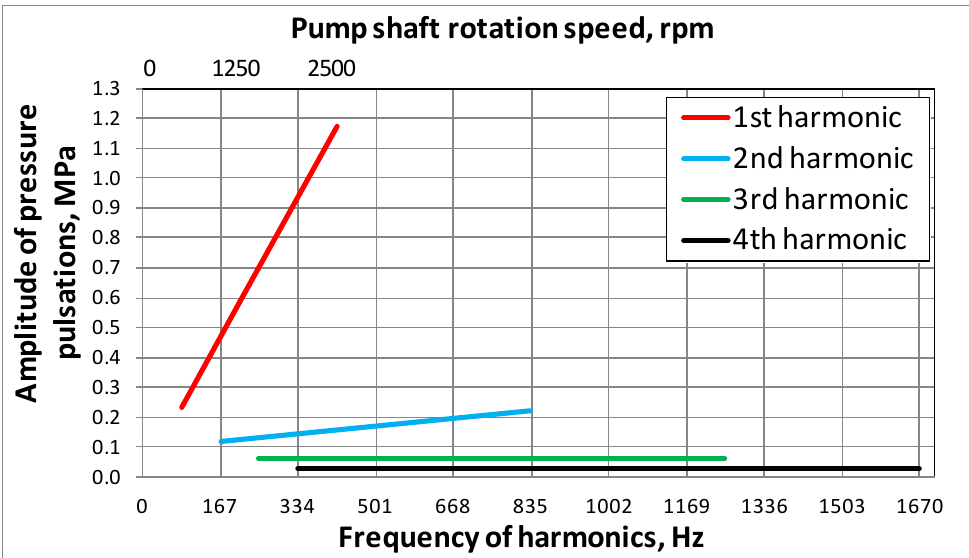
Figure 24. Amplitudes of pressure pulsations at the pump outlet. The maximum analyzed component of the oscillation spectrum k max with a reliably defined amplitude and initial phase on it should be determined by the condition when the amplitude of pressure pulsations A p at this harmonic is greater than the absolute error of the measuring device: where m is the coefficient determining how many times A p exceeds the error of the mea- suring device, and ∆ d is the absolute error of the measuring device. At m = 1, the amplitude A pmin is determined with an error of 100%, and at m = 10, it is determined with an error of 10%. It is rational to choose the coefficient m in the range m = ( 100 . . . 10 ) , which will allow us to determine the amplitude A p with an error of (1 ... 10)%.